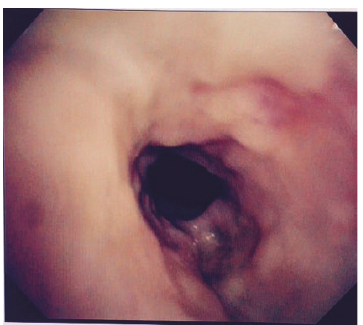
Figure 3: Area below vocal cord following administration of saline jet with sloughing of tracheal mucosa.